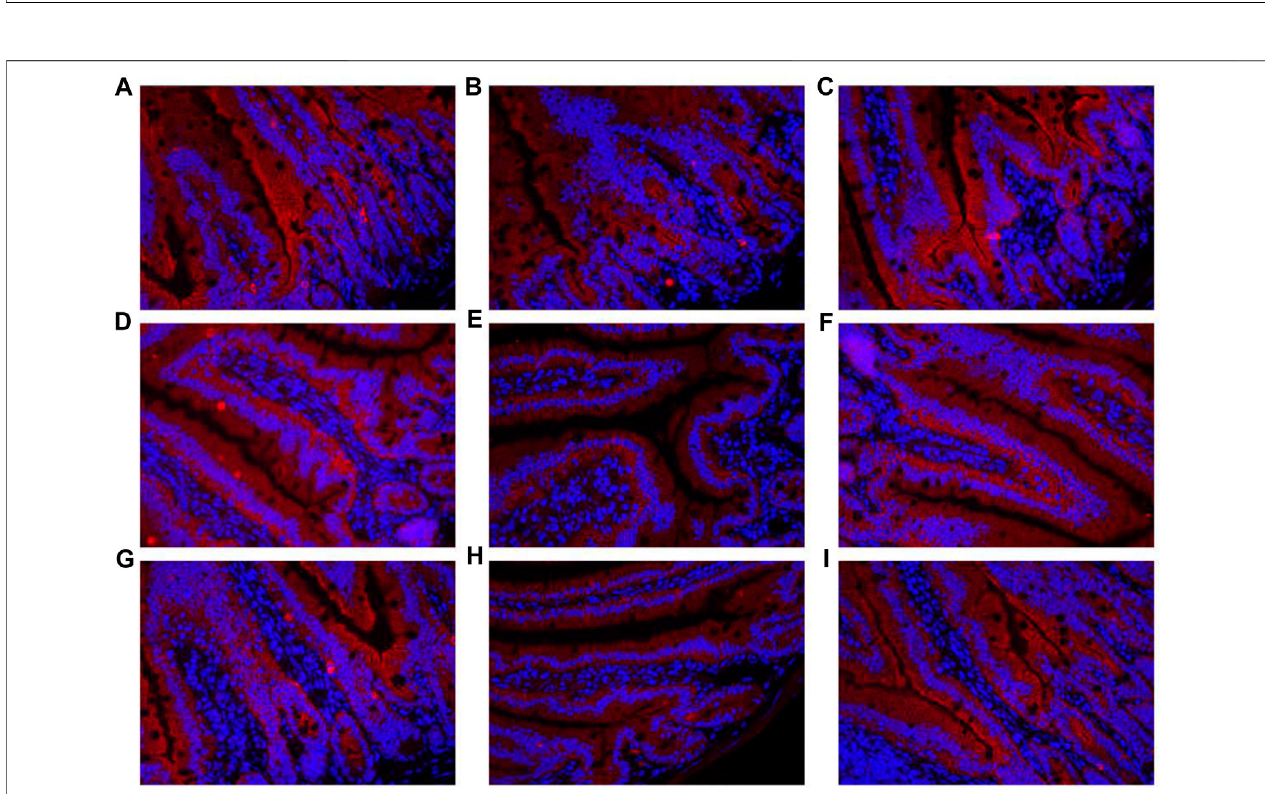
FIGURE 11 | Immuno fl uorescence of tight junction protein expressions in jejunum of mice. (A) – (C) Expressions of Claudin-1 in the jejunum of NS (A) , RS (B) and RS-P (C) groups. (D) – (F) ExpressionsofOccludininthejejunumofNS (D) ,RS (E) andRS-P (F) groups. (G) – (I) ExpressionsofZO-1inthejejunumofNS (G) ,RS (H) and RS-P (I) groups. The tight junction proteins of. ZO-1-, claudin-1- and occludin are stained red, and the magni fi cation of all the fi gures are 40 × .